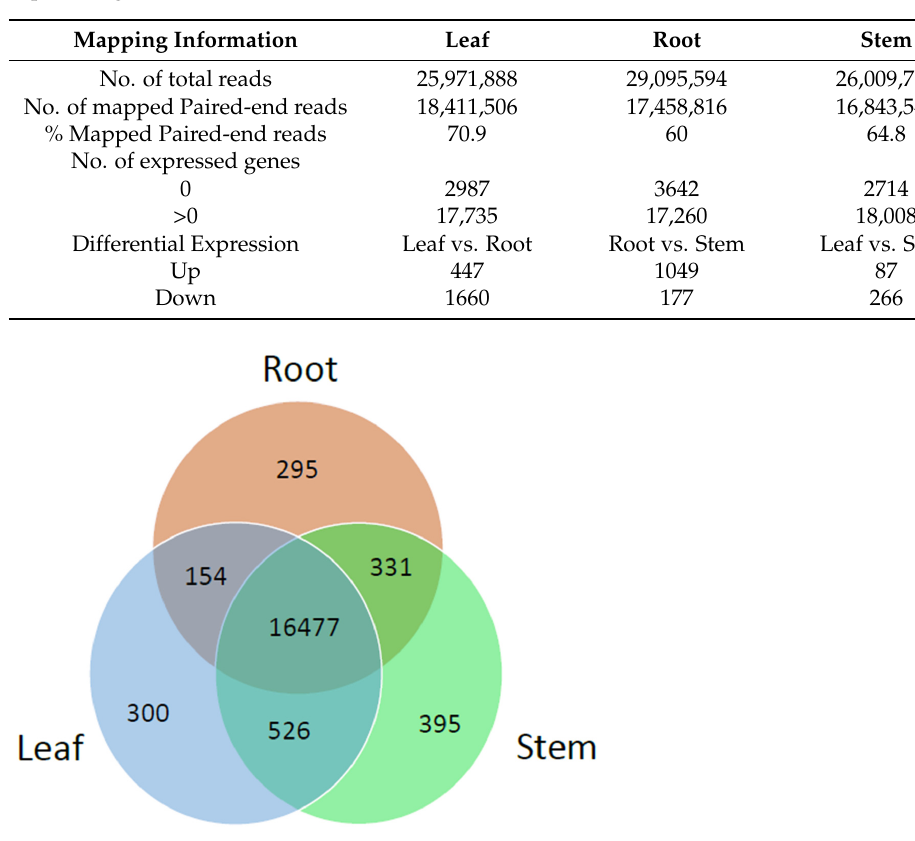
Table 4. Mapping information of the Illumina sequence reads and the results of differentially expressed genes.